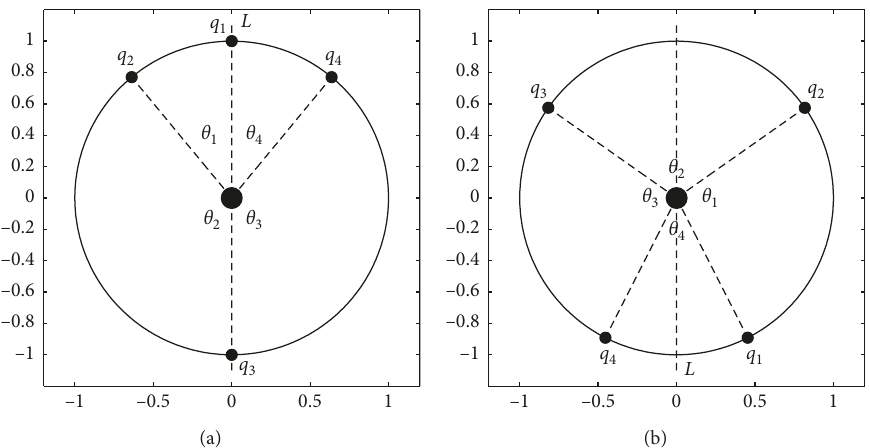
Figure 2: Symmetric configurationfor the1+4bodyproblem.(a)Symmetric configurationwith θ